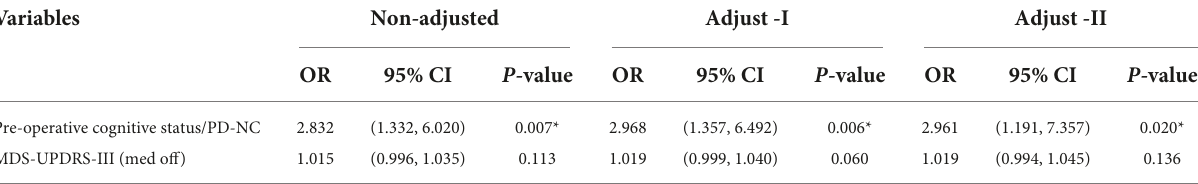
TABLE 5 Impact of pre-operative cognitive status (PD-NC) and MDS-UPDRS-III (med-off) on post-operative cognitive decline (multivariate logistic regression models).